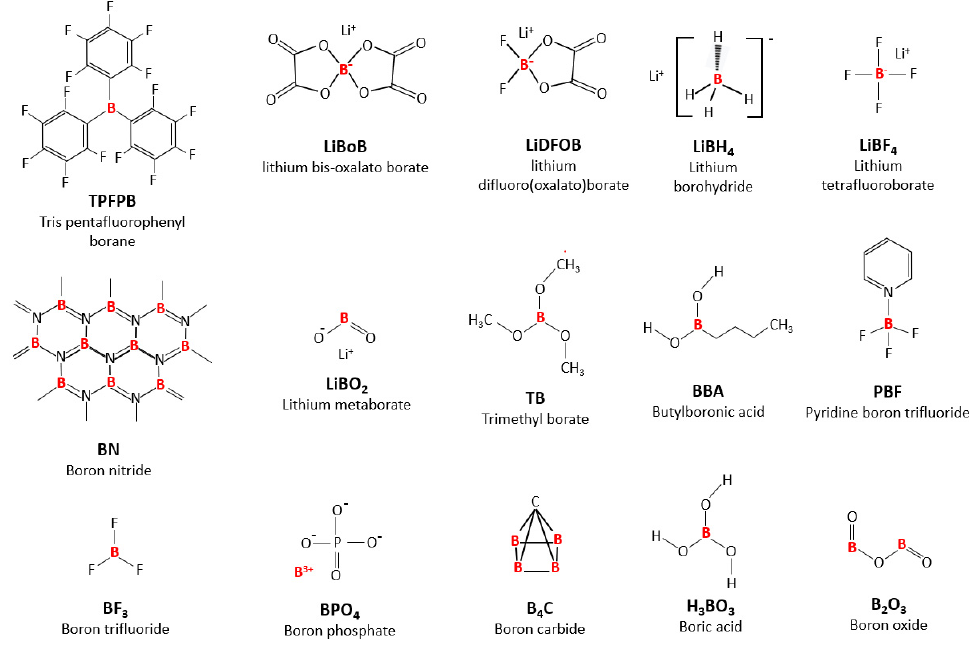
Figure 2. Molecular structure of boron compounds mentioned in the review.